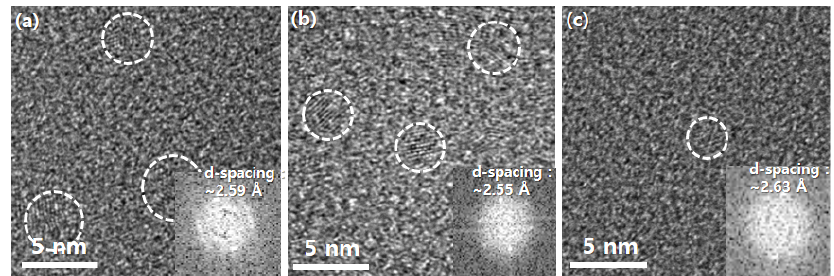
Figure 3. TEM images of SiC nanoparticles captured with the gas ratios of (SiH 4 + CH 4 )/H 2 of ( a ) 0.04, ( b ) 0.02 and ( c ) 0.01.